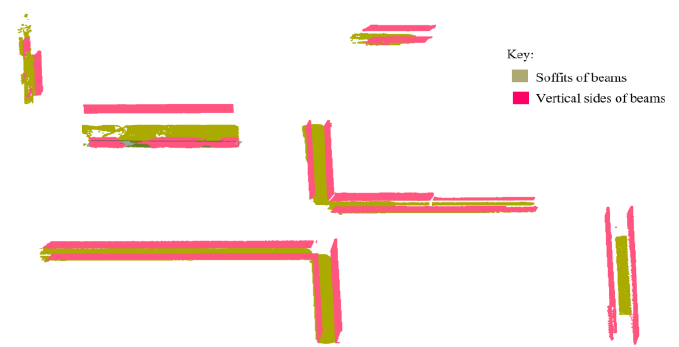
Figure 21. The detected soffits and vertical sides of the second-floor beams.